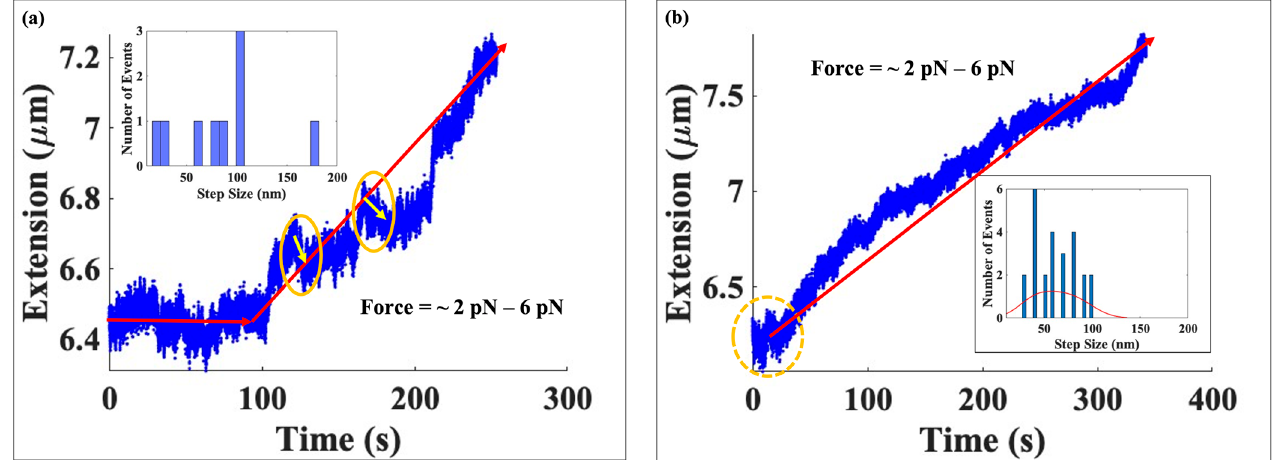
Figure 3. Two graphs of extension vs. time one for native (left) and another for hyperacetylated histones (right), in the low force range from ~2 pN to ~6 pN . ( a ) The extension of the DNA tether complexed with native histones showing the reconstituted chromatin extended from ~6.5 μ m to ~ 7.3 μ m . We found a total of nine unbinding occurrences, which are shown in the step-size histogram—see the inset in the left top corner. Arrows inside the solid yellow circles indicate DNA tether recompaction events in this force range, while the red lines are visual guides to the pattern of tether extension. ( b ) A single DNA tether bound with hyperacetylated histones subject to increasing forces from ~2 pN to ~6 pN as in ( a ) of this figure. The tether extension increased from ~6.3 µ m to ~7.8 µ m. In this force range, we found 25 discrete occurrences, which were used to construct the step-size histogram shown in the inset on the right bottom. The dashed circle shows the region where first unbinding event was observed, and the red line is a visual guide to the pattern of tether